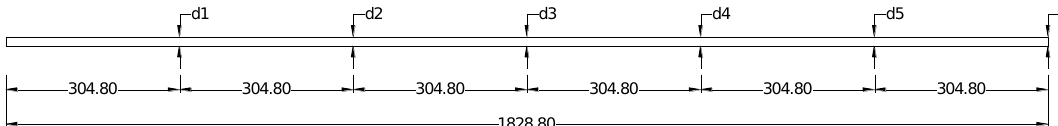
Figure 1. Diameter schedule for rebars (dimensions are in mm).